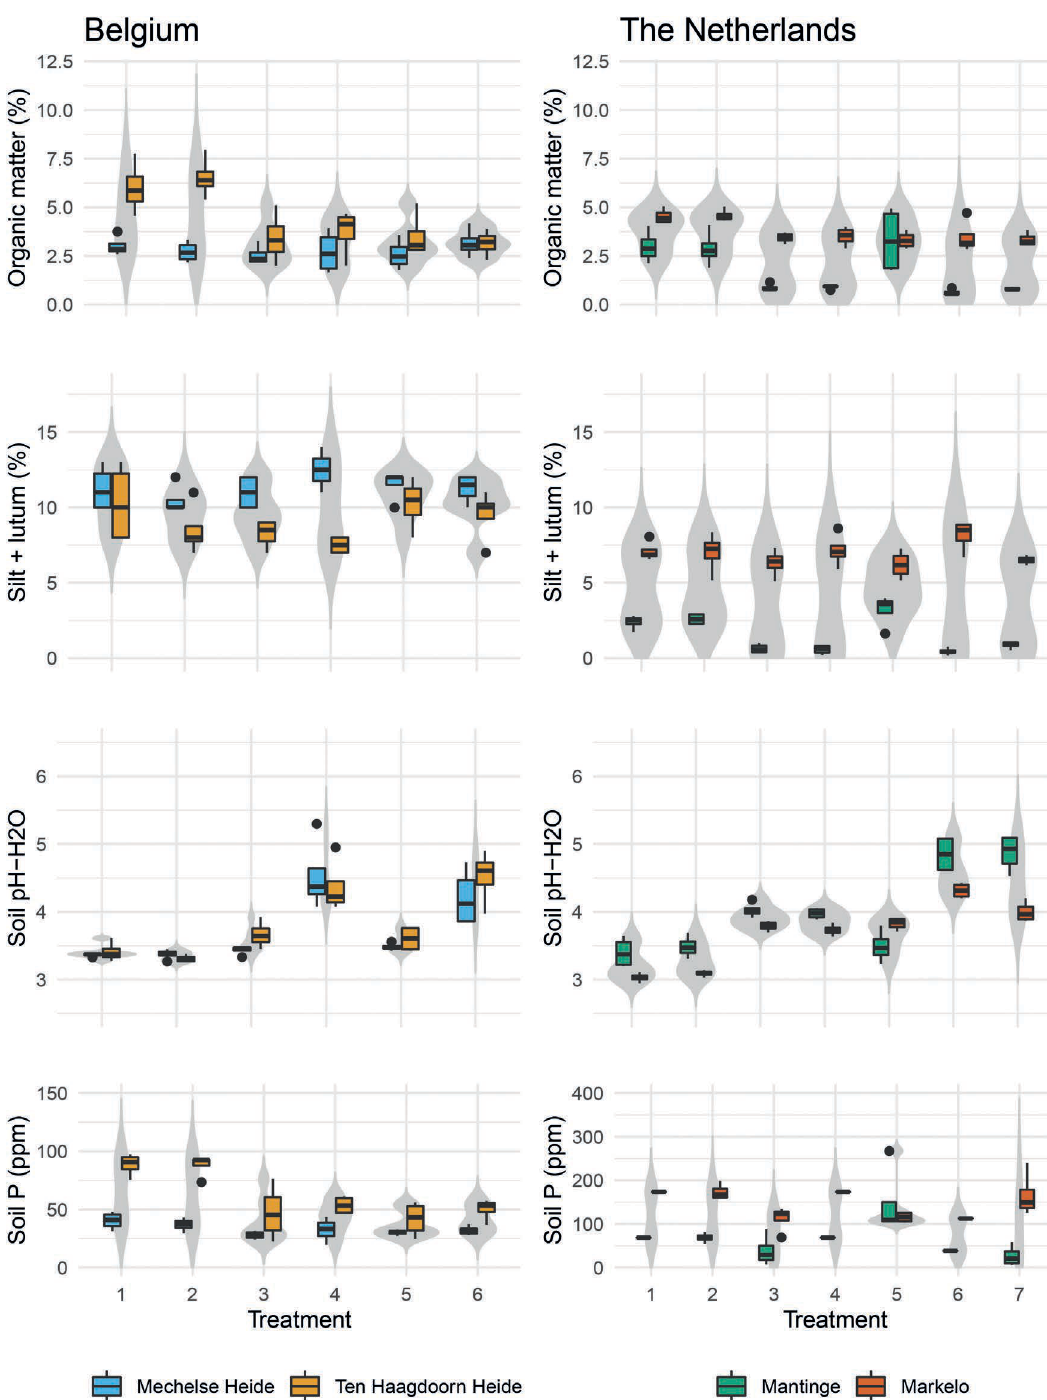
Figure 1 – The response of the soil characteristics to the experimental treatments. Treatments in Belgium were 1: control, 2: fencing, 3: fencing + deep sod cutting, 4: fencing + deep sod cutting + lime addition, 5: fencing + deep sod cutting + rotavation, 6: fencing + deep sod cutting + lime addition + rotavation. Treatments in the Netherlands were: 1: fencing, 2: fencing + shallow sod cutting, 3: fencing + deep sod cutting, 4: fencing + deep sod cutting + litter addition, 5: fencing + deep sod cutting + rotavation, 6: no fencing + deep sod cutting + lime addition, 7: fencing + deep sod cutting + lime addition. The total number of plots was n = 104; n = 48 in Belgium (24 per location) and n = 56 in the Netherlands (28 per